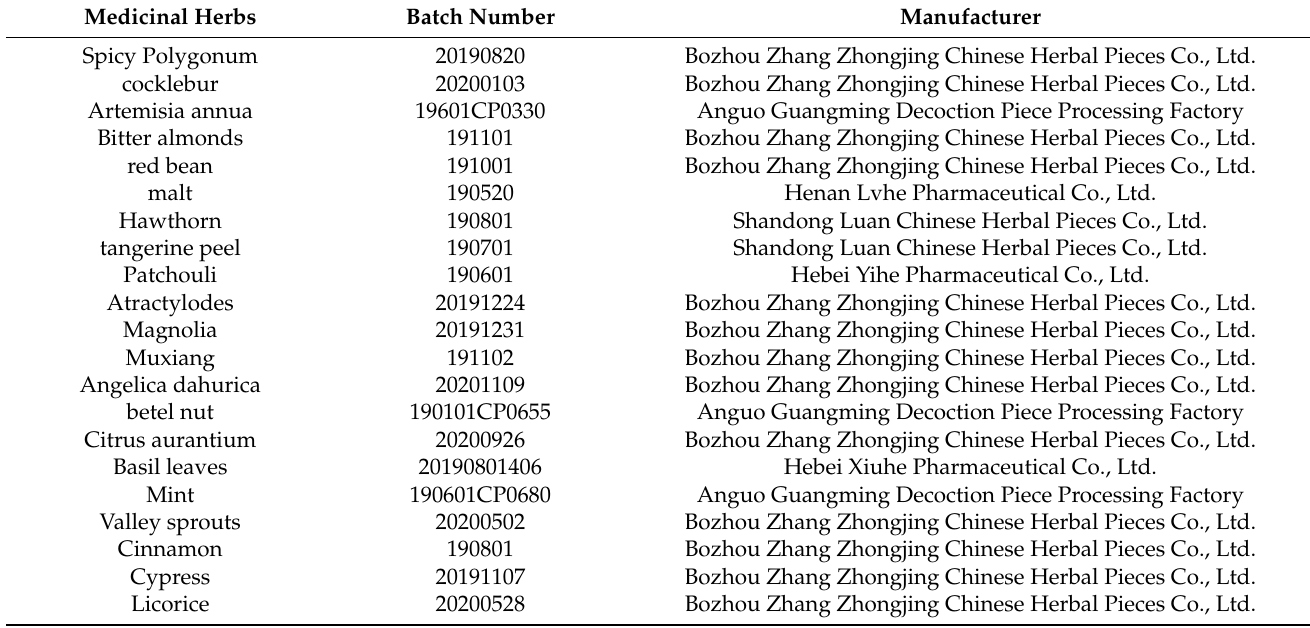
Table 7. Experimental medicinal materials and batch numbers.